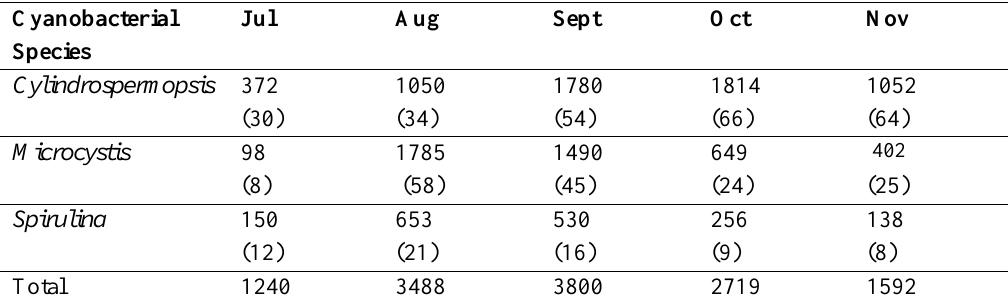
Table 1 : Dominant and sub-dominant cyanobacterial counts (cfu/ml*) of Unnichai tank. Numbers in parentheses are their % relative